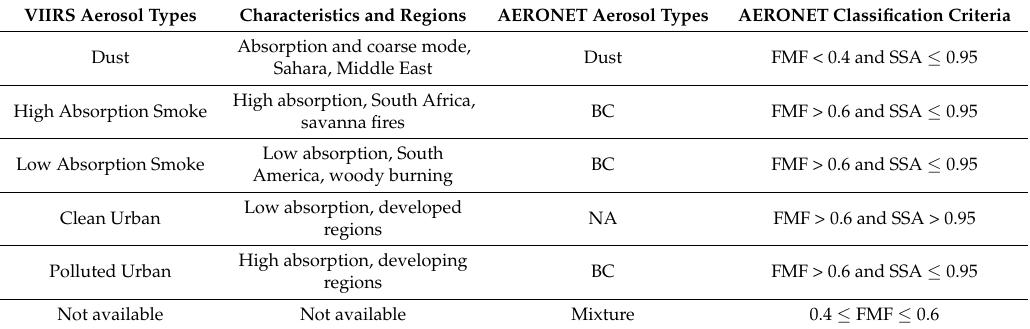
Table 1. VIIRS aerosol types and their corresponding AERONET aerosol types. Abbreviation in this table: Aerosol Robotic Network (AERONET), non-absorbing (NA), black carbon (BC), single-scattering albedo (SSA) and fine-mode fraction